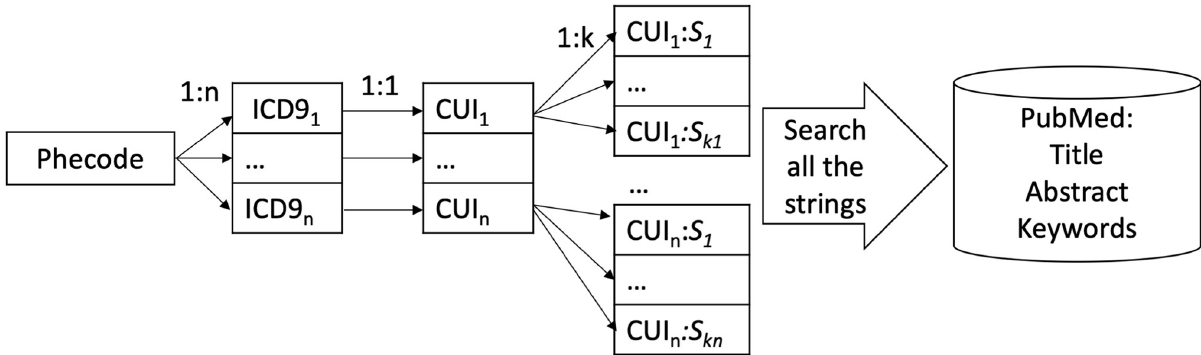
Fig 2. Searching PubMed for associations. For each Phecode, all the ICD-9 codes associated with it are mapped to their CUIs (concept unique identifiers). Next, all the strings associated with the CUIs in UMLS metathesaurus are identified. These strings are used to search all the titles, abstracts and keywords in the PubMed database to identify the counts of academic research papers associated with each phecode.